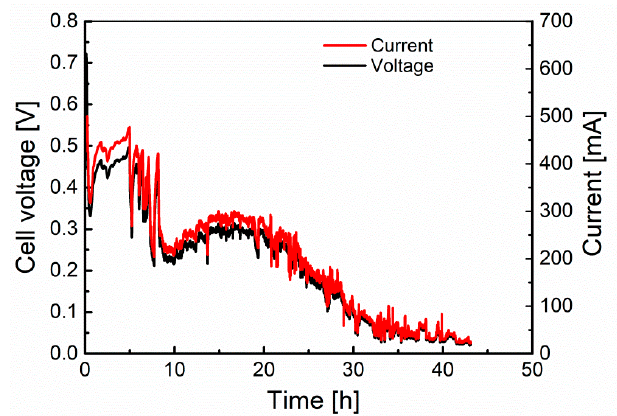
Figure 21. The variation of the fuel cell voltage and current vs. time during the long-term experiment test of the model III MH-DCFC.